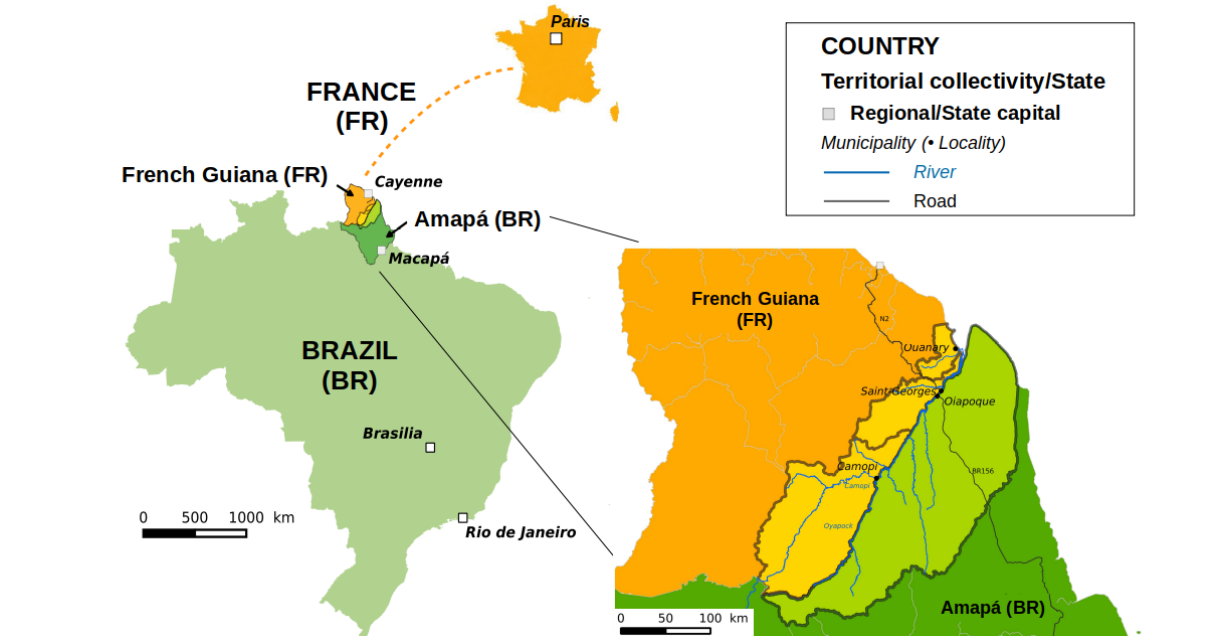
Figure 1. Cross-border area delimitation and administrative structuration of the